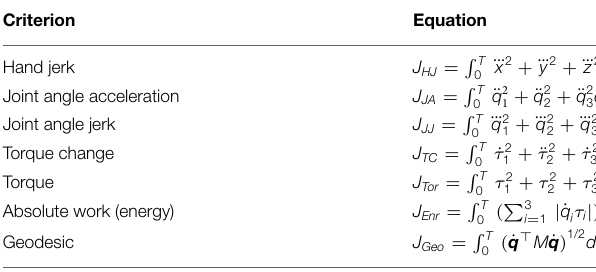
TABLE 1 | Cost functions proposed in literature. Criterion